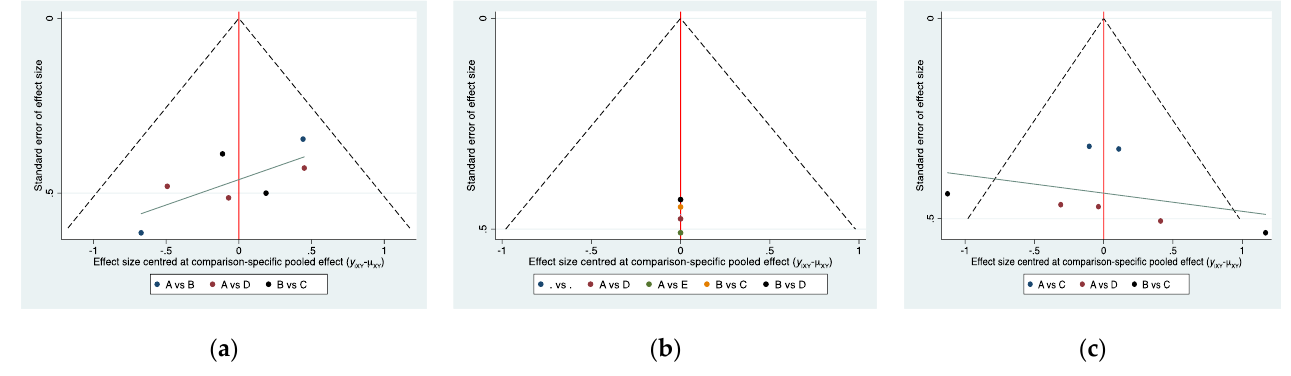
Figure 7. Funnel plot of publication bias. ( a ) 10 m sprint; ( b ) 20 m sprint; ( c ) COD. Table 3. Rankings for 10 m sprint, 20 m sprint, and COD for different types of